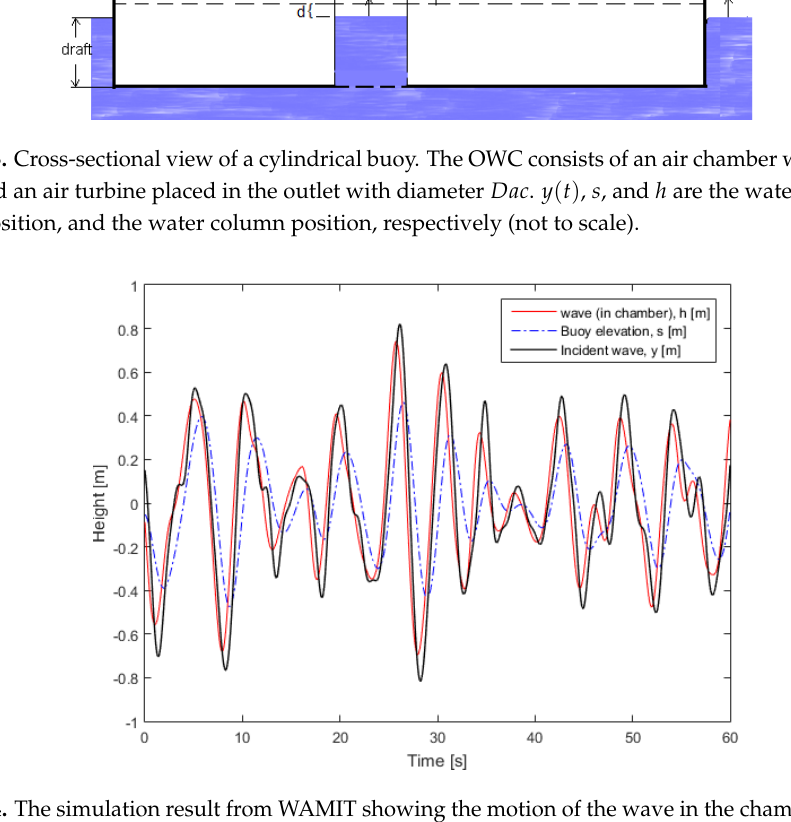
Figure 4. The simulation result from WAMIT showing the motion of the wave in the chamber, the buoy, and the incident wave. The incident wave, y , is the most commonly occurring sea state (Wave1) in the region of study. Table 2. The oscillating water column (OWC) model